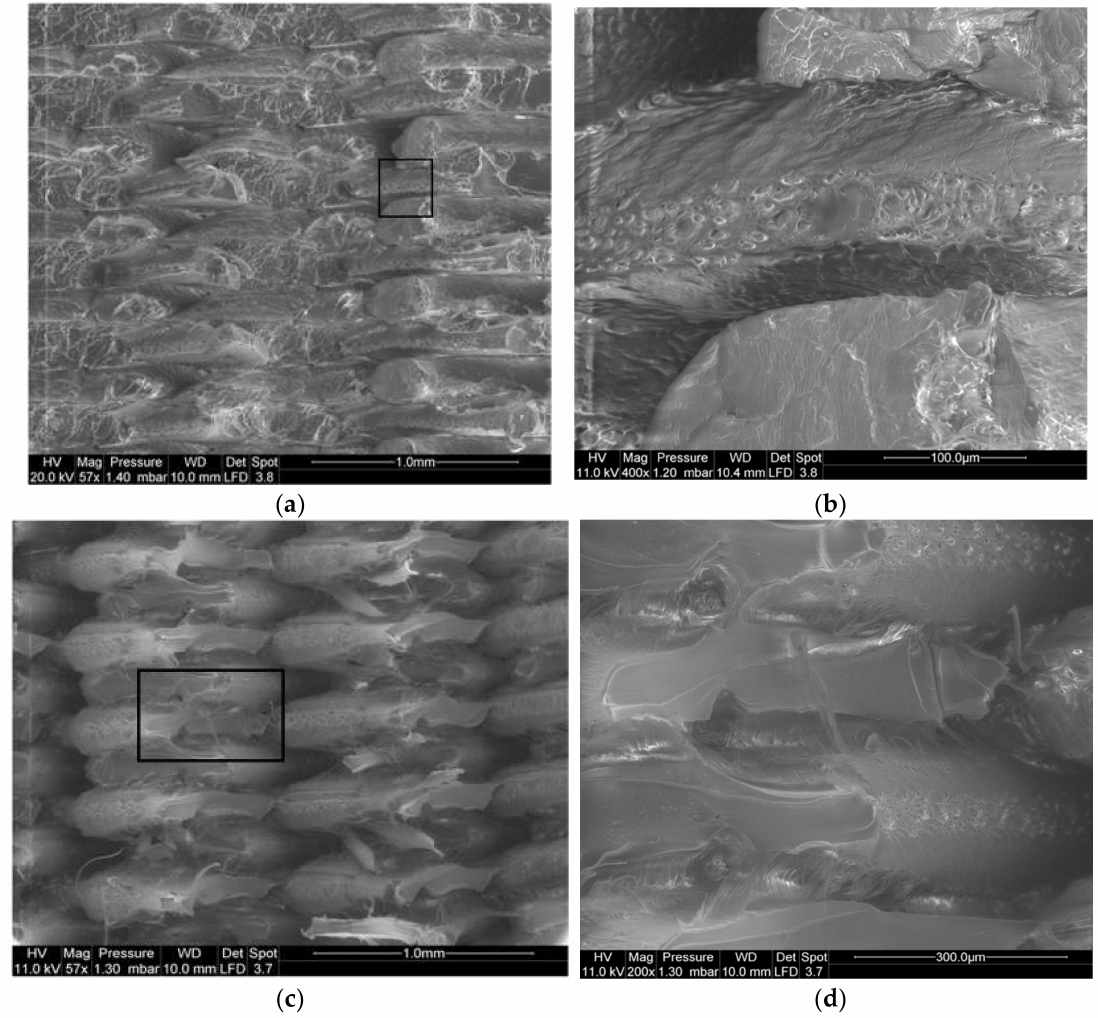
Figure 7. SEM micrographs showing the effect of bed temperature on the topography of PLA fractured surfaces (T C = 200 ◦ C, Θ = 0 ◦ ): ( a ) T B = 50 ◦ C scale of filament layup; ( b ) T B = 50 ◦ C zoomed-view on filament cross-section; ( c ) T B = 60 ◦ C scale of filament layup; ( d ) T B = 60 ◦ C zoomed-view on filament